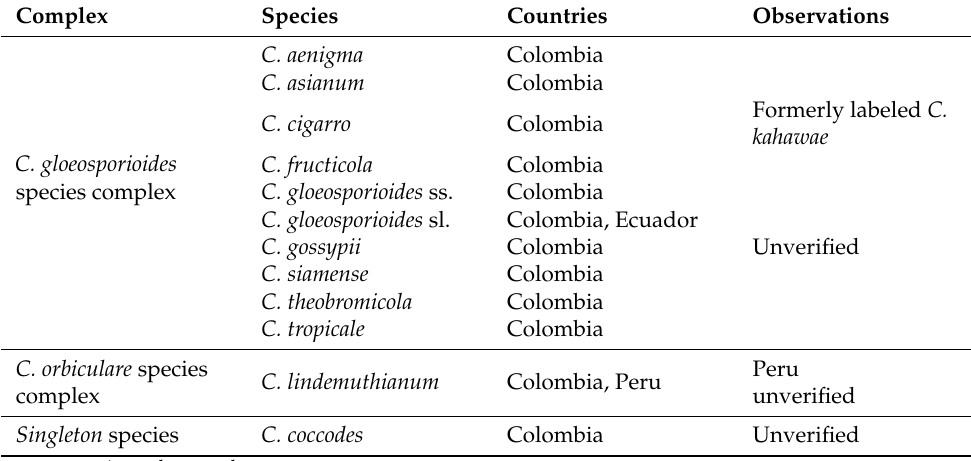
Table 1. Cont. Complex Species Countries